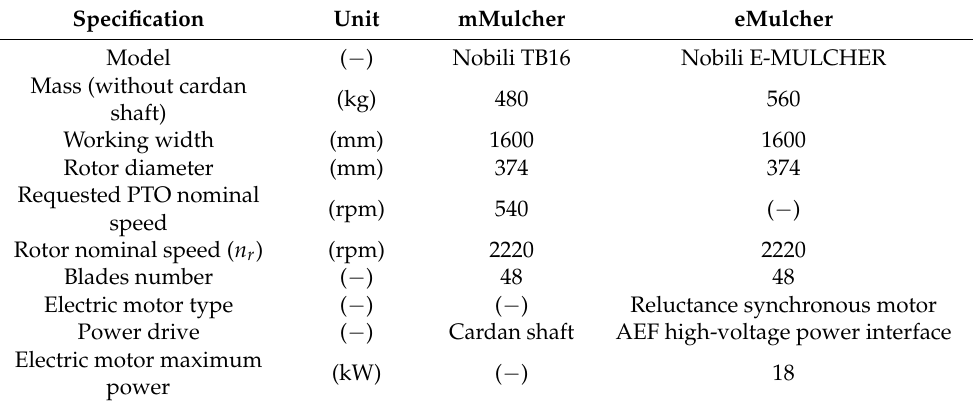
Figure 5. mMulcher ( a ) and eMulcher ( b ) developed by Nobili S.p.a. (Molinella (BO), Italy) used for the tests. Table 4. mMulcher and eMulcher specifications.